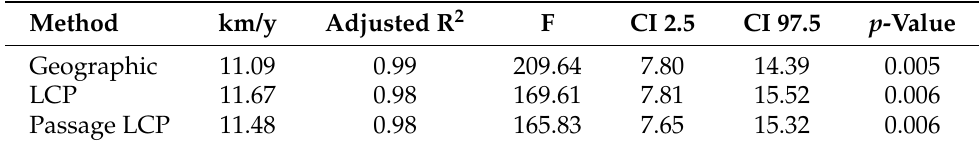
Figure 8. Simple linear regression of cumulative maximum distances of R. nitidula spread in the Odra River basin calculated with geographic, LCP, or passage LCP methods. Table 3. Results of simple linear models of rate of R. nitidula expansion in the Odra River basin based on three methods of distance calculation.